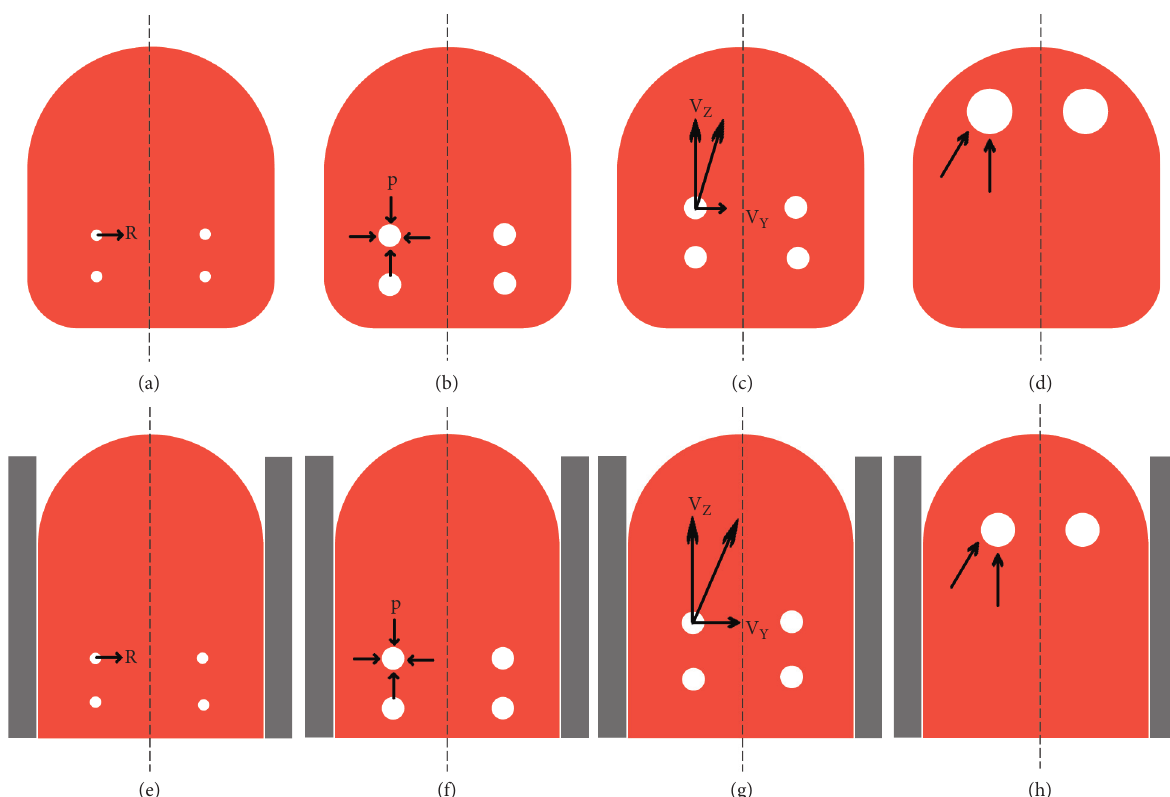
Figure 10: Pore nucleation growth and movement fusion of the deposition wall: (a–d) without the path constraint and (e–h) with the copper plates constrained